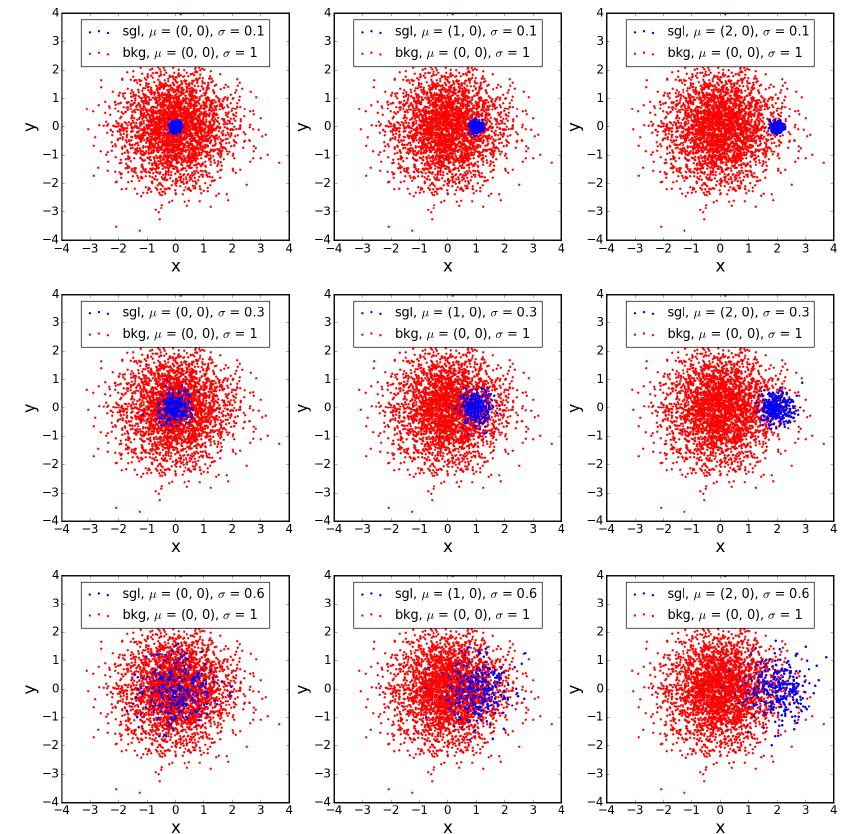
Figure 3 . 2D Gaussian samples used for testing. Each contains 100000 background events and 1000 signal events. For convenience, we label these benchmark points, as “BP 1”, . . . , “BP 9”, from left to right and from top to